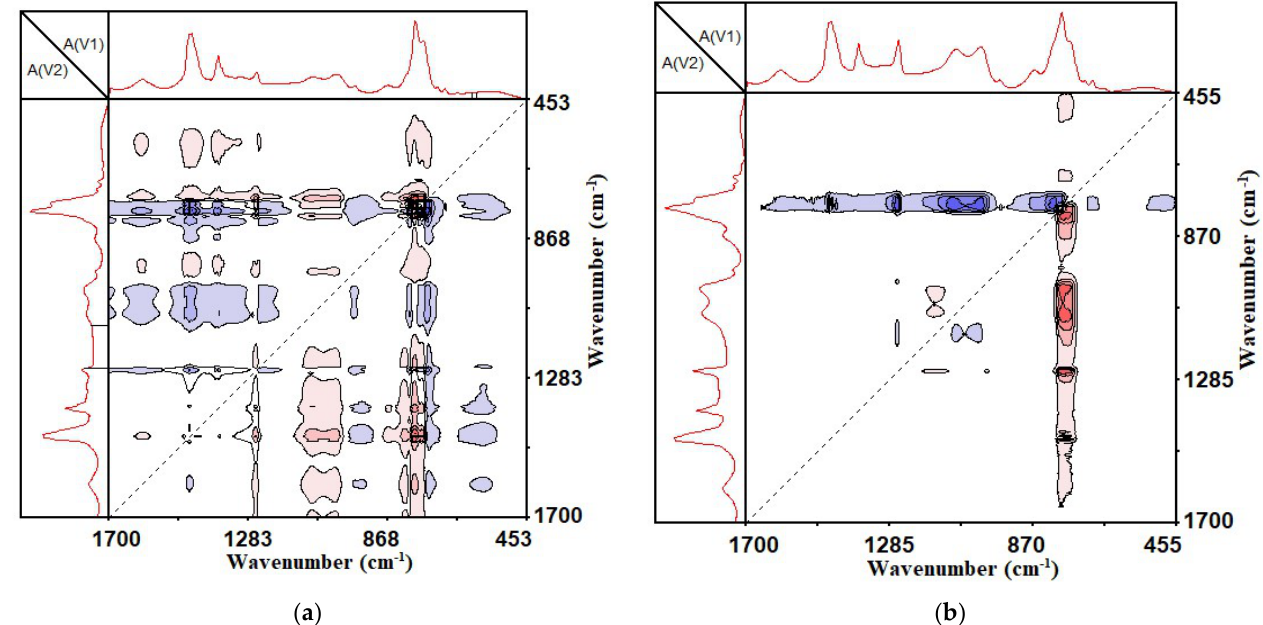
Figure 9. Two-dimensional asynchronous infrared correlation spectrum of 1700~450 cm −1 . ( a ) SBS-modified asphalt binder; ( b ) SBS + 1% CNTs composite-modified asphalt binder.